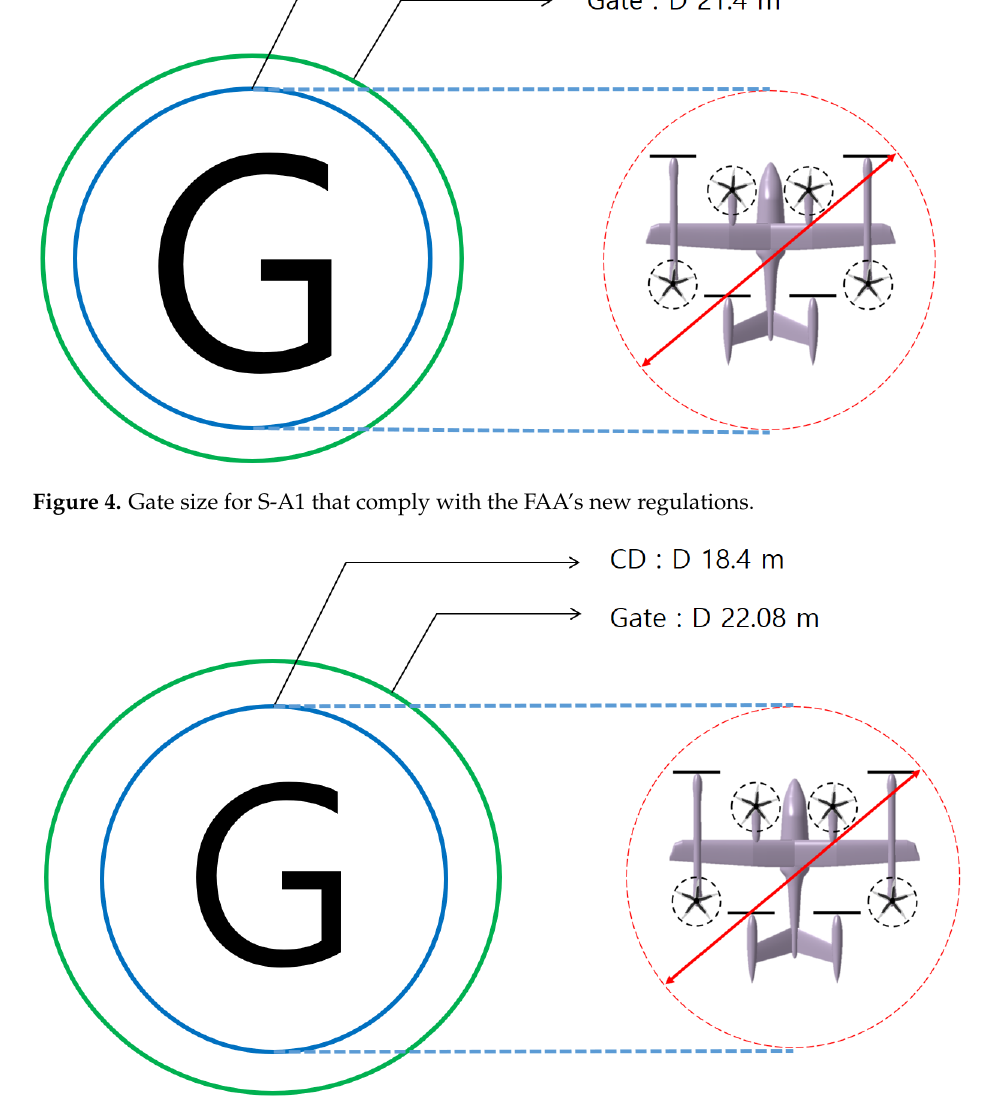
Figure 5. Gate size for S- A1 that comply with the EASA’s new regulations.